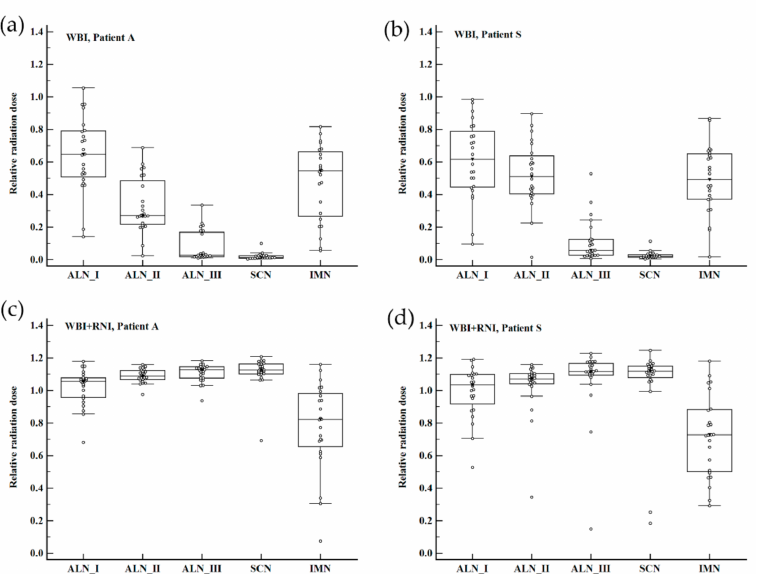
Figure 2. Box-and-whisker plots for relative nodal radiation dose according to the regional node group and treatment arms among 24 participating institutions. ( a ) WBI in Case A, ( b ) WBI in Case S, ( c ) WBI + RNI in Case A, and ( d ) WBI + RNI in Case S. Abbreviation: WBI, whole-breast irradiation; WBI + RNI, whole-breast irradiation plus regional nodal irradiation; ALN I, axillary node level I; ALN II, axillary node level II; ALN III, axillary node level III; SCN, supraclavicular lymph node; IMN, internal mammary lymph